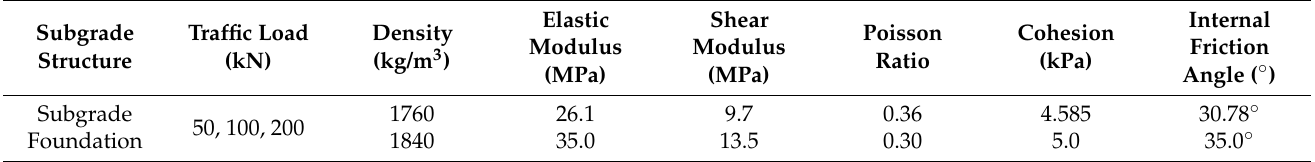
Table 5. Numerical-model parameters.